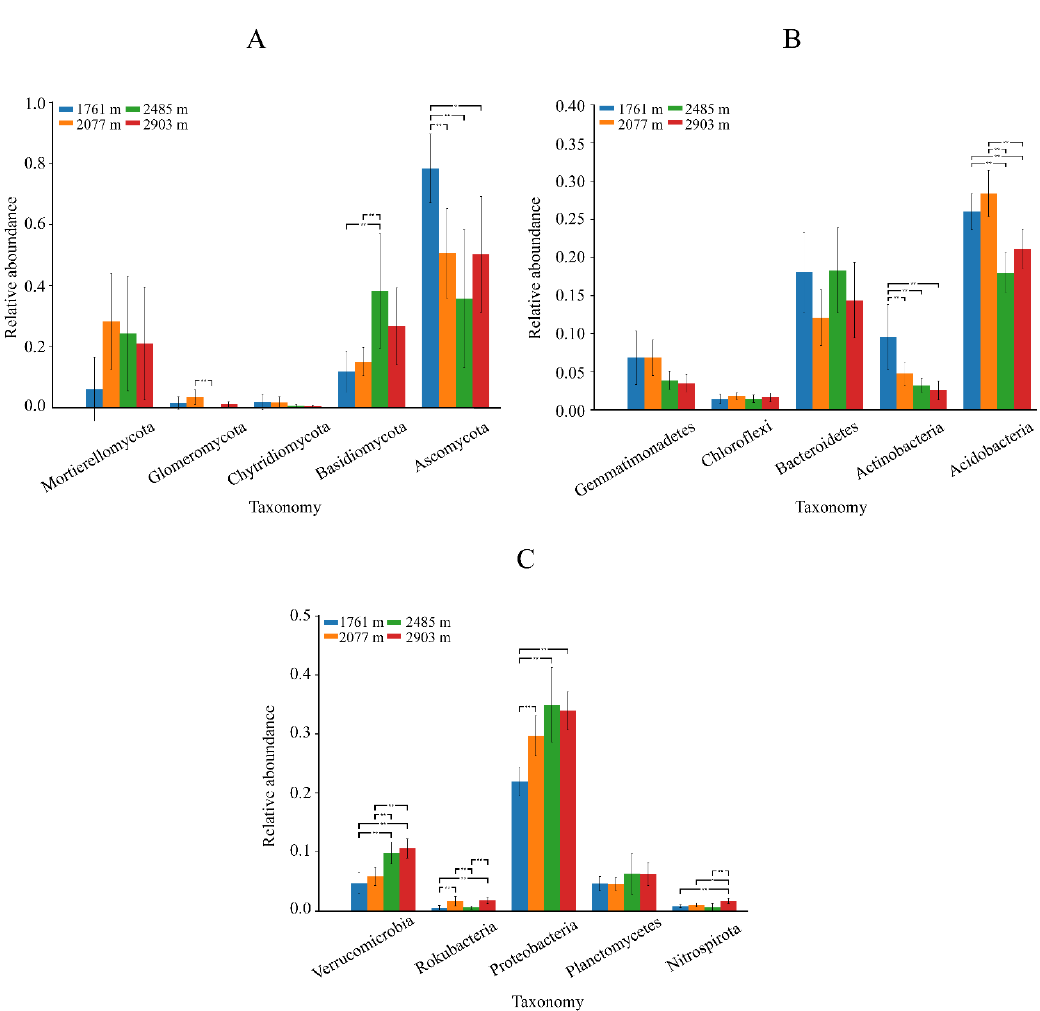
Figure 4. Comparison of the relative abundance of major phyla of fungi ( A ) and bacteria ( B , C ) in the soil communities at different elevations. Asterisks indicate significance level. Signif. Codes: p < 0.05 (*), p < 0.01 (**), p > 0.05 (blank). Among the bacterial communities, Proteobacteria significantly increased ( F = 22.4559, p < 0.001) in relative abundance moving up the elevation gradient (Figure 4B), whereas Acidobacteria were significantly more abundant ( F = 12.3158, p < 0.001) at lower (1761 and 2077 m) than higher elevations (2485 and 2903 m). The relative abundance of Bacteroidetes did not significantly change along the elevation gradient (Figure 4C).